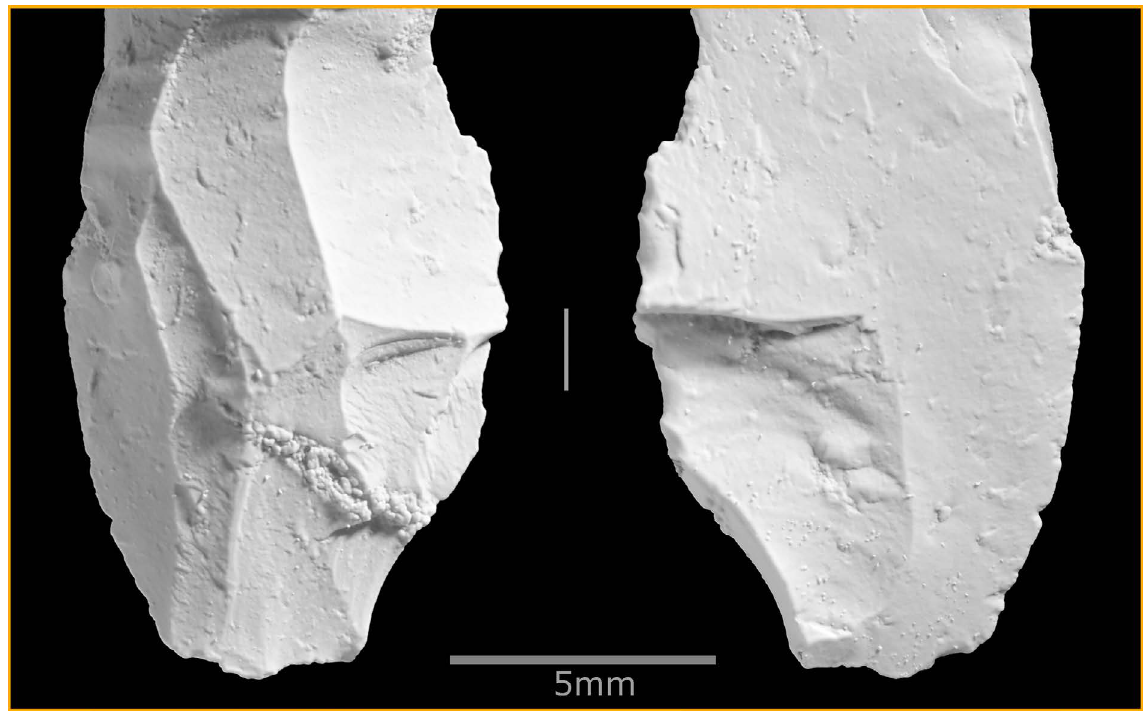
Figura 7. Lapa dos Coelhos, camada 3: lamela com esquirolamento do bolbo, evidenciado por pulverização com óxido de magnésio (Foto de J. P. Ruas). Figure 7. Lapa dos Coelhos, layer 3: bladelet presenting splintering of the butt evidenced by covering with magnesium oxide (Photo by J. P. Ruas).